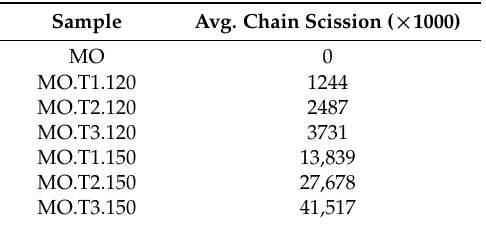
Table 5. Average number of chain scissions of the paper